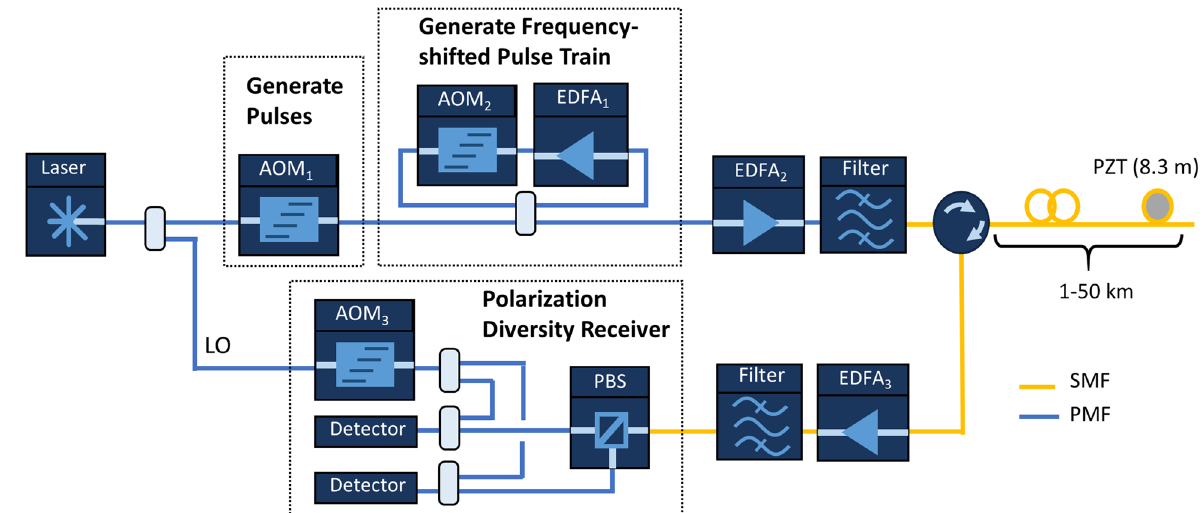
Figure 3. Experimental setup used to interrogate the fiber with a train of frequency shifted pulses. A single narrowband laser is divided into an interrogation and LO arm. AOM 1 generates 100 ns pulses and introduces a frequency shift of 195 MHz. AOM 2 controls the number of pulses in the pulse train and imparts a + 100 MHz frequency shift between pulses. AOM 3 shifts the LO by − 55 MHz to offset the interference terms between the LO and the RBS light from the cross-terms formed by interference between RBS light from different pulses in the pulse